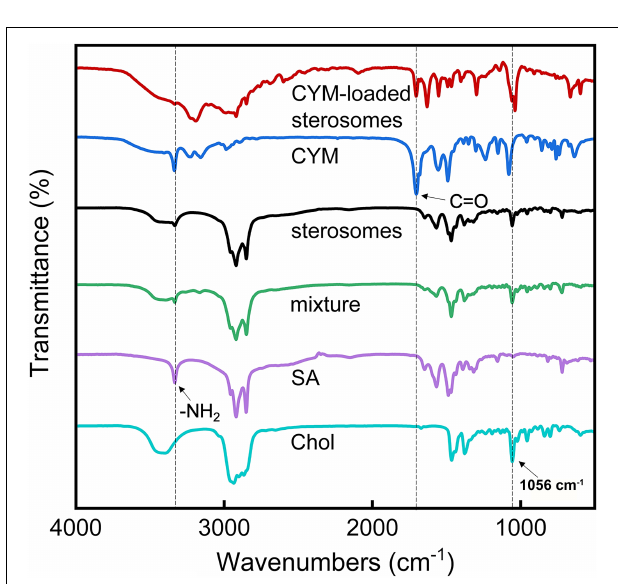
FIGURE 6 | Effects of CYM-loaded sterosomes on growth parameters of the S. cerevisiae yeast in yeast extract peptone dextrose (YPD) medium.